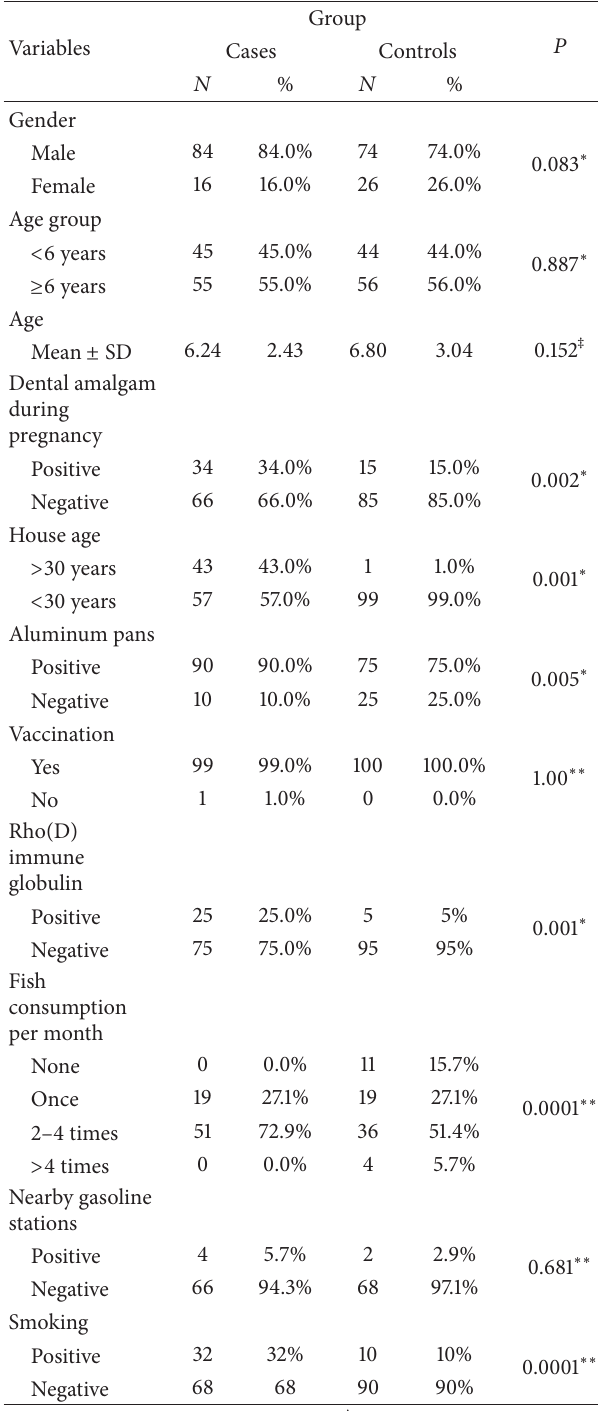
Table 1: Statistical comparison between characteristics and risk factors of patients and controls ∗